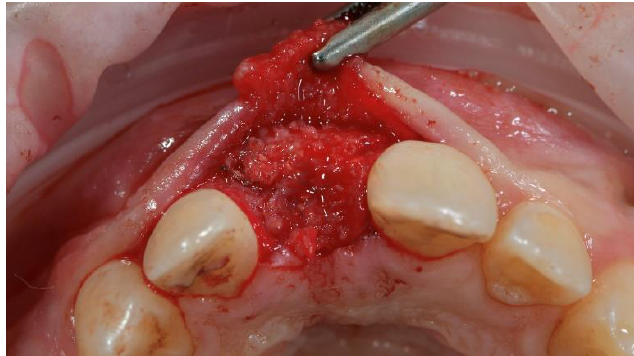
Figure 8. Second-stage surgery: titanium mesh removal and soft-tissue management.